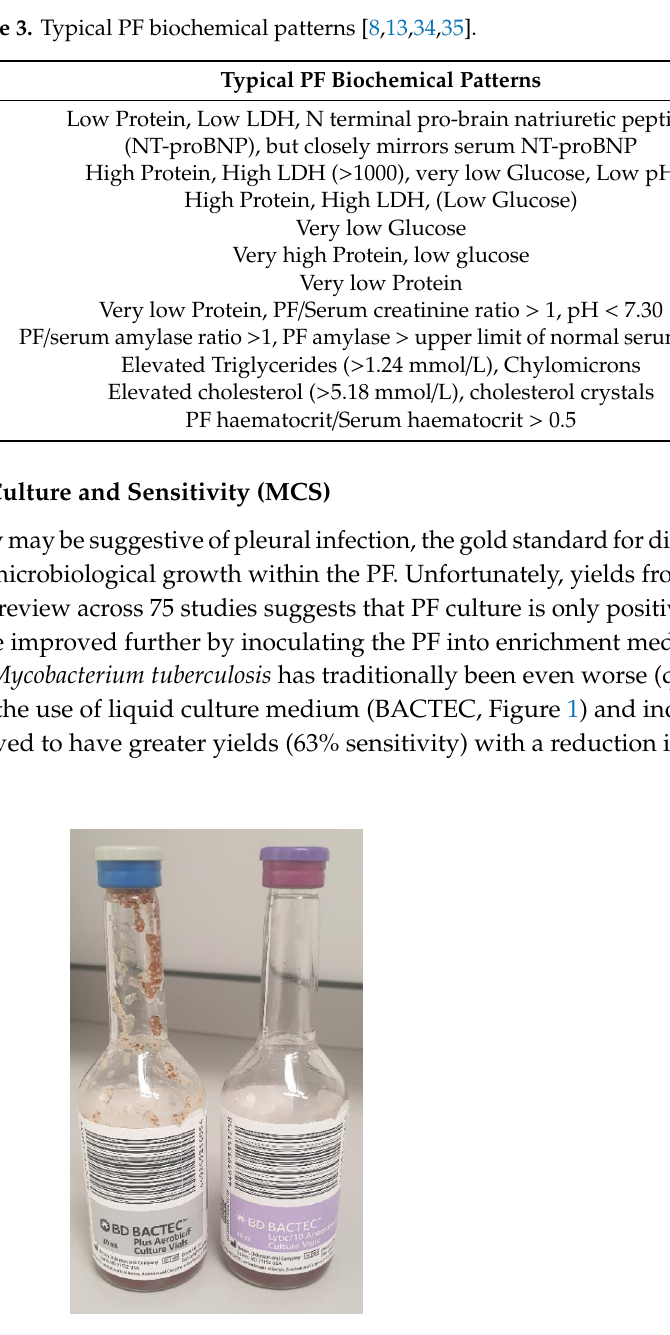
Figure 1. BACTEC bottles.